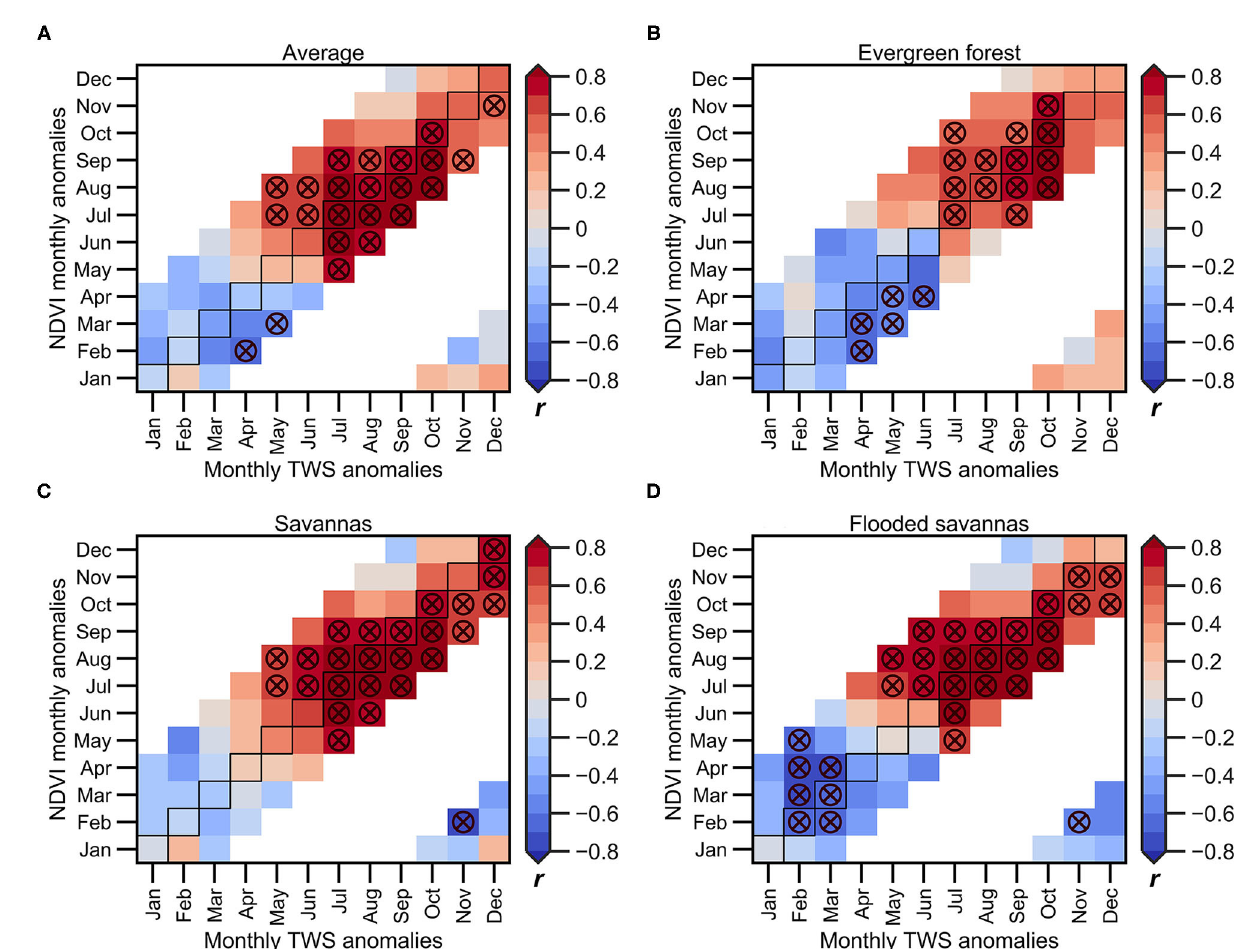
FIGURE 9 | 2003–2015 monthly lagged correlations between TWS and NDVI anomalies averaged over the upper Madeira Basin for each predominant land cover types: (A) entire basin, (B) evergreen forests, (C) savannas, and (D) flooded savannas. The NDVI anomalies of the predominant land cover types are calculated below the 1,000m.a.s.l. The horizontal axis indicates the month corresponding to the TWS anomalies, while the vertical axis indicates the month of response of the NDVI. Circles marked with the X symbol indicate significant correlations ( p < 0.05). Not computed correlation coefficients are shown in white